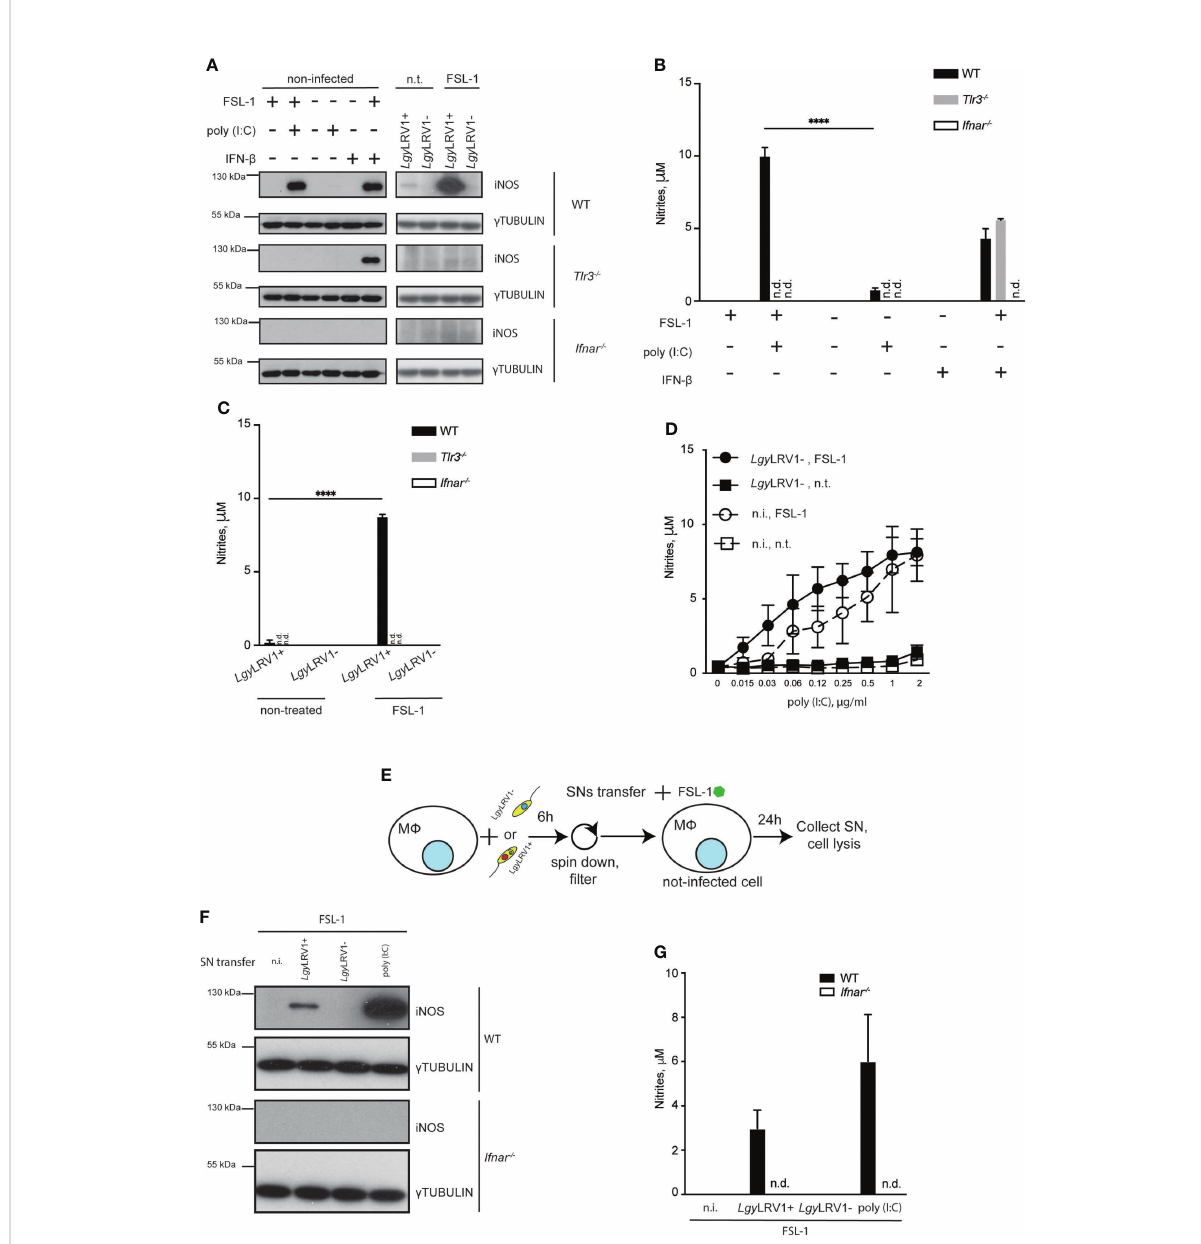
FIGURE 3 Lgy LRV1+ triggered type I IFNs are necessary but not suf fi cient in order to induce iNOS in an auto- and paracrine manner. (A) WT, Tlr3 -/- or Ifnar -/- BMDMs were infected with Lgy LRV1+ or Lgy LRV1- (MOI 10), stimulated with poly (I:C) (2 m g/ml), FSL-1 (10 ng/ml), IFN- b (500 U/ml), alone or in combination, or left untreated for 12h. Total cell lysates were analyzed by western blot for iNOS and g -tubulin expression. (B, C) WT, Tlr3 -/- or Ifnar -/- BMDMs were treated as in (A) for 48h. SNs were collected and levels of nitrites were measured using Griess assay. (D) WT BMDMs were infected with Lgy LRV1- (MOI 10), treated with FSL-1 (10 ng/ml) alone or in combination. Except one, all conditions were treated with poly (I:C), with one of eight two-fold serial dilution concentrations ranging from 2 to 0.015 m g/ml. Upon 48h SNs were collected and levels of nitrites were measured using Griess assay. (E) scheme depicting experiments performed in (F, G) . (F, G) WT BMDMs were infected with Lgy LRV1+ or Lgy LRV1- (MOI 10), stimulated with poly (I:C) (2 m g/ml), or left untreated. Upon 6h, SNs were collected, fi ltered with 22 um fi lter, supplemented with FSL-1 (10 ng/ml) and added to the fresh set of untreated WT and Ifnar -/- BMDMs. Upon 24h, SNs from treated BMDMs were collected and levels of nitrites were measured using Griess assay (G) . Total cell lysates were analysed by western blot for iNOS and g -tubulin expression (F) . Data show mean ± SD from a representative of three independent experiments (B, C, F) . Representative blots are shown from at least three independent experiments in (A, F) . the following: ****p < 0.0001, n.i. – non-infected. n.t. – non-treated. n.d. - not